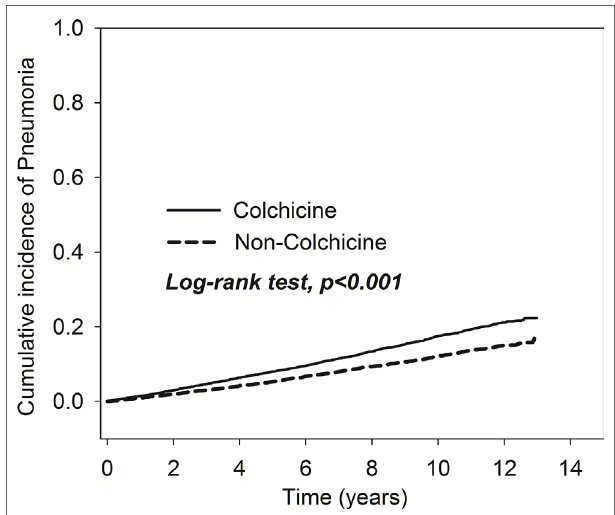
FIGURE 2 | Comparison of cumulative incidences of pneumonia in the patients with and without taking colchicine.